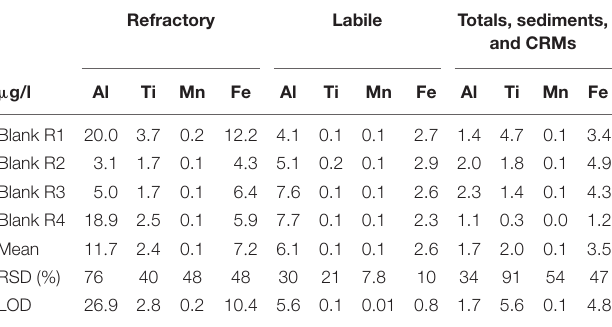
TABLE 1 | Blanks and associated statistics for the SF-ICP-MS analysis in µ g/L. Refractory Labile